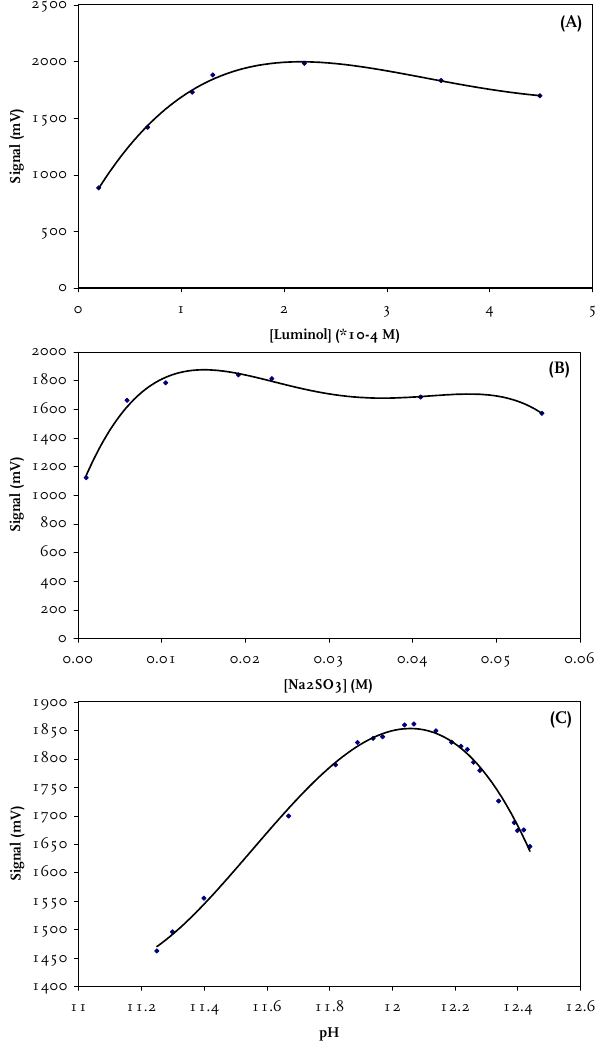
Fig. 4. Optimum concentration experiment for luminol (A) , Na 2 SO 3 (B) and KOH (C) . (A) and (B) show signal (mV) versus concentration (M=mol/l), (C) shows signal (mV) versus pH value. A constant concentration of 1.4ppmvNO 2 is used. The standard deviation of the measurements is on the order of 20mV. The black line is a 4th order polynomial fit. The optimal concentration ranges are shown in Table 1. 81 ppbv PAN) to 1.2% of the signal (in combination with Triton